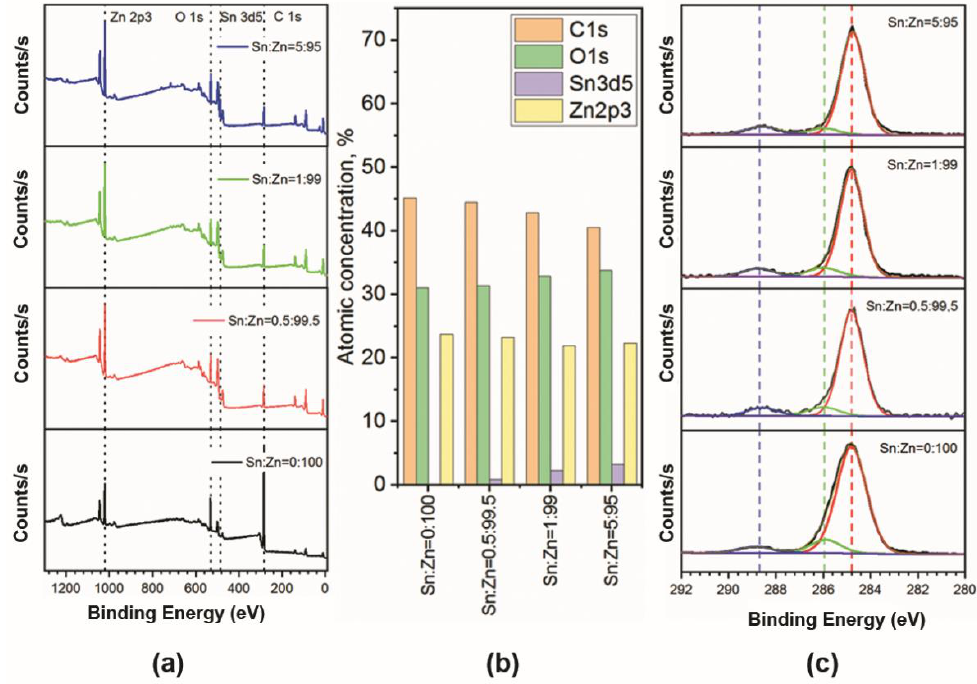
Figure 7. Survey spectra of pure ZnO and ZnO-SnO 2 samples with Sn:Zn = 0.5:99.5, Sn:Zn = 1:99, Sn:Zn = 5:95 ratios ( a ), atomic concentration of presented elements ( b ), high-resolution spectra of C 1s ( c ).